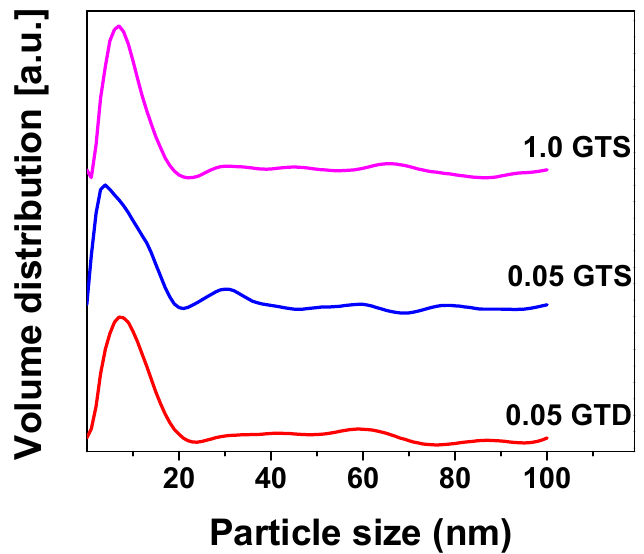
Figure 4. TiO 2 particle size distribution of GT composites by SAXS analysis.